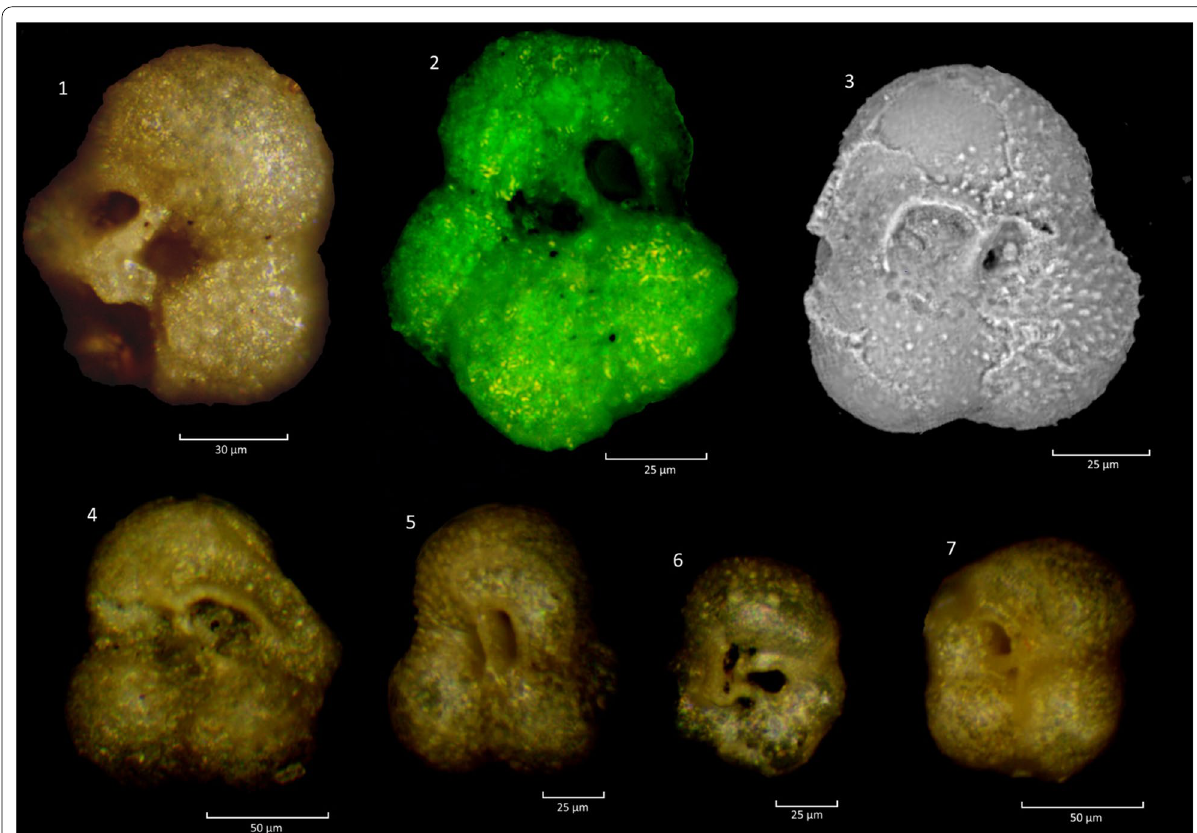
Fig. 3 Globuligerina oxfordiana (Grigelis). Nos. 1, 2, 3, 4, 5, 6 and 7 specimens with extra apertural opening (without rim or lip). Nos. 1 and 3—sample 6, Morrisi Zone, middle Bathonian, Gnaszyn, Poland. Nos. 2, 4, 5, 6 and 7— Mariae Zone, lower Oxfordian, Le Havre,